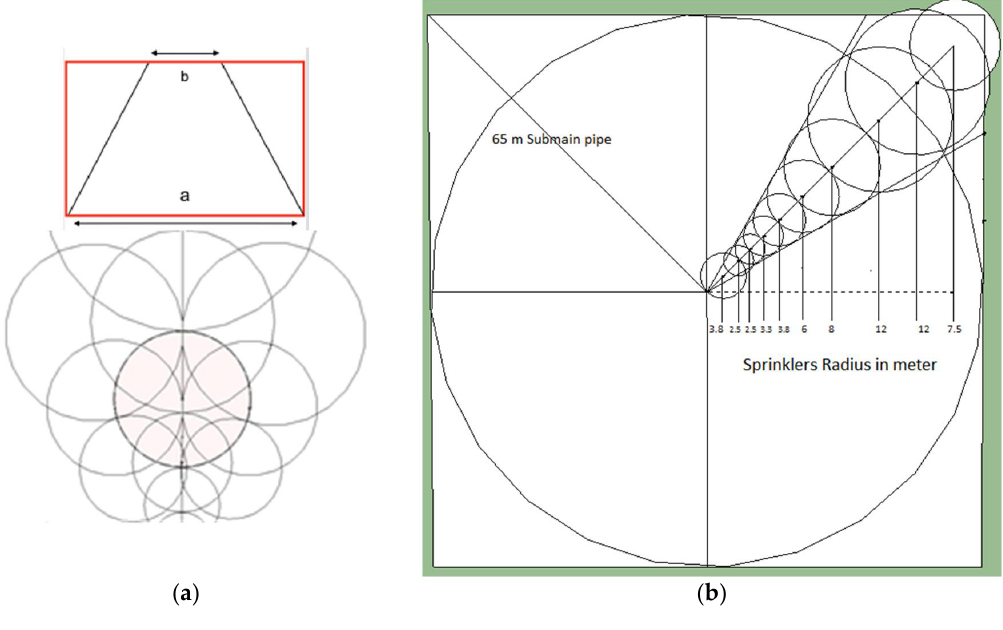
Figure 2. ( a ) CHL sprinklers overlapping and ( b ) radiuses along the lateral.